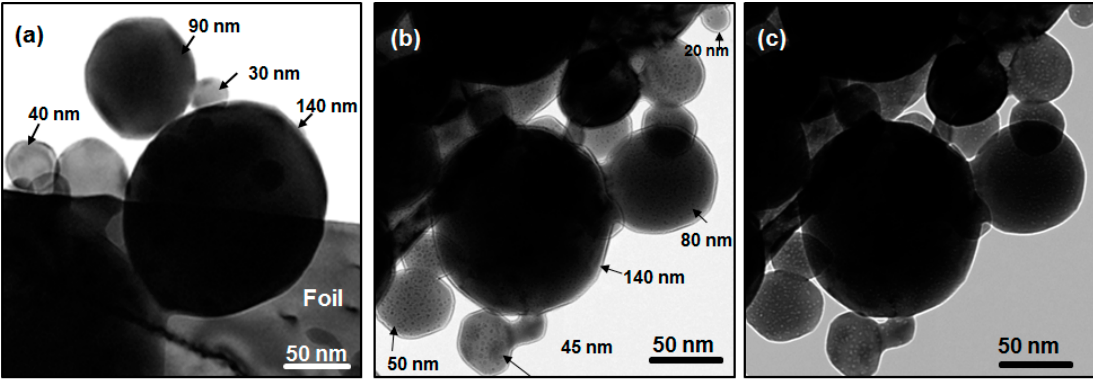
Figure 2. Bright-field TEM images showing the distribution of bubbles in W NPs of different sizes after irradiation with 15 keV He to a fluence of 9.6 × 10 16 ions · cm − 2 at 750 ◦ C showing: ( a ) a distribution of NPs of different sizes dispersed at the edge of the electropolished region of a W foil before irradiation; ( b ) 800 nm overfocus; and ( c ) 800 nm underfocus after irradiation. Small bubbles appear as black spots in overfocus and white spots in underfocus.